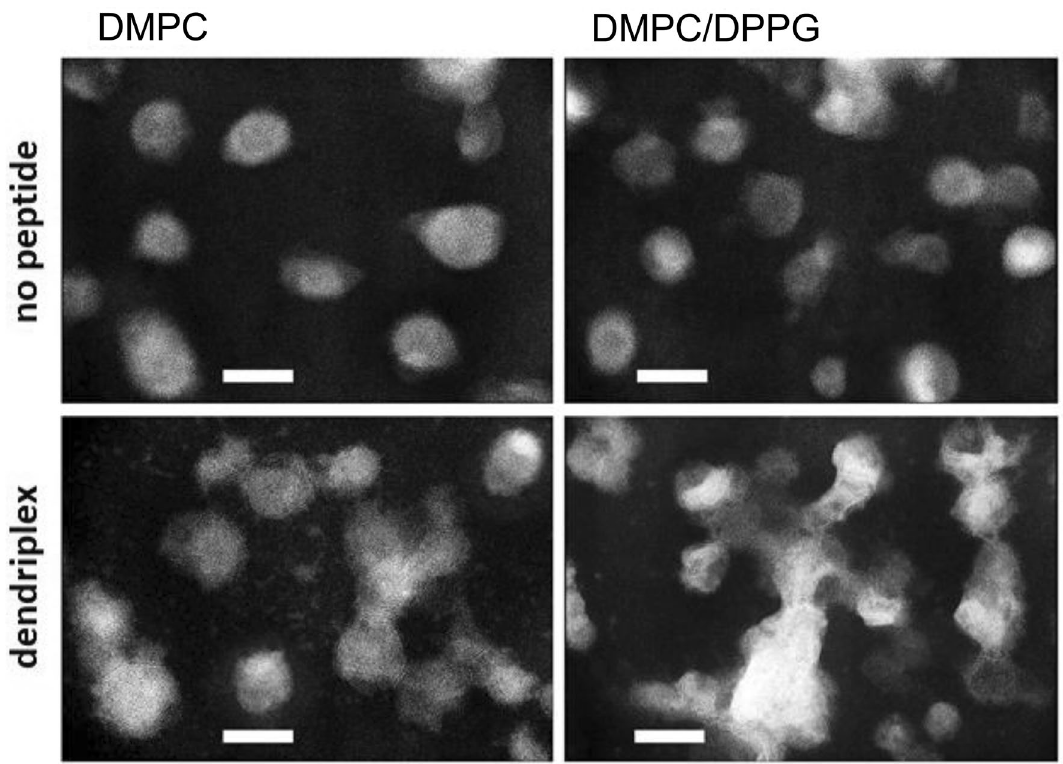
Figure 4. Electron micrographs corresponding to DMPC or DMPC/DPPG lipid vesicles (upper panel) and their mixture with a dendriplex p24/ CPD-G3 , dendriplex/lipid molar ratio 0.04 (lower panel). Dendriplexes were formed in a 10 mM Na-phosphate buffer, pH 7.4 and immediately mixed with liposome suspension. A magnification of ×100,000 was used to examine the samples. Bar = 100 nm. To obtain greater contrast, the color of the microphotographs has been inverted.